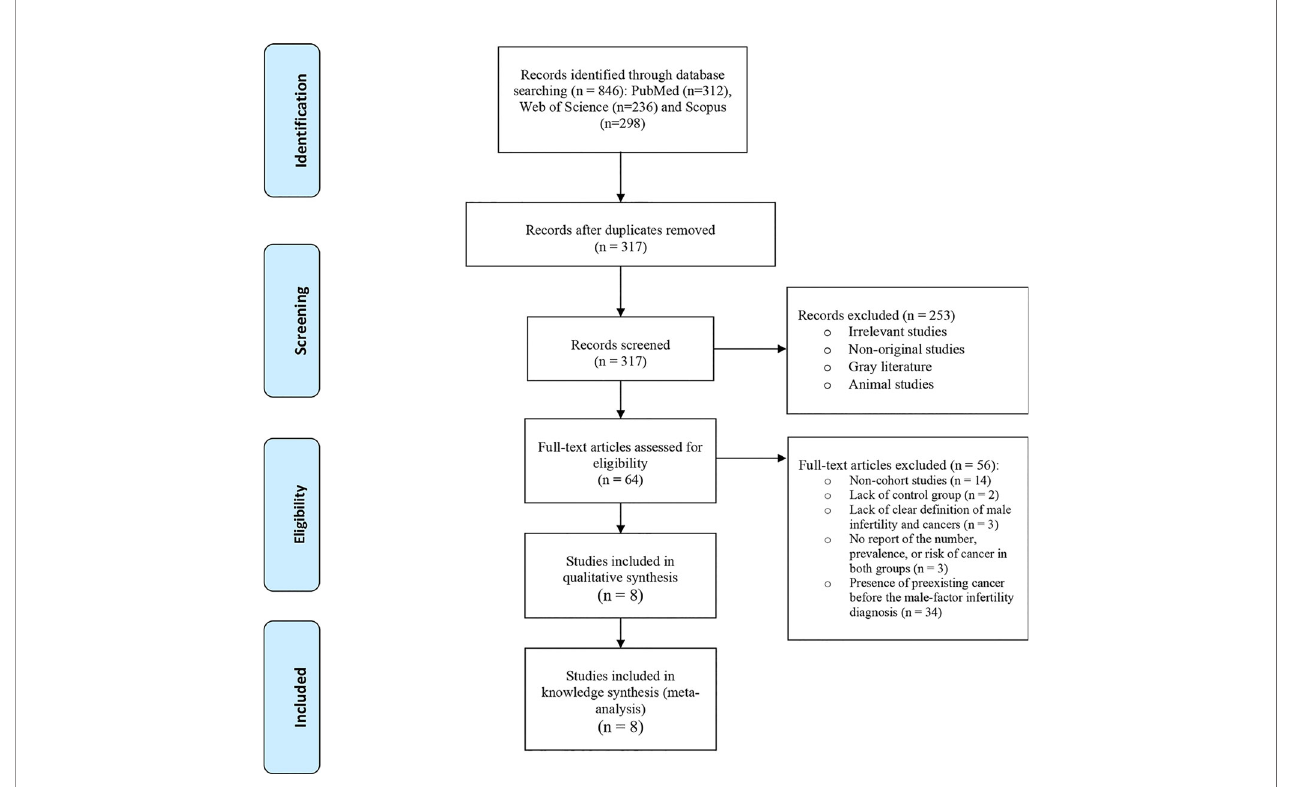
FIGURE 1 | Flow diagram of the search strategy and study selection.